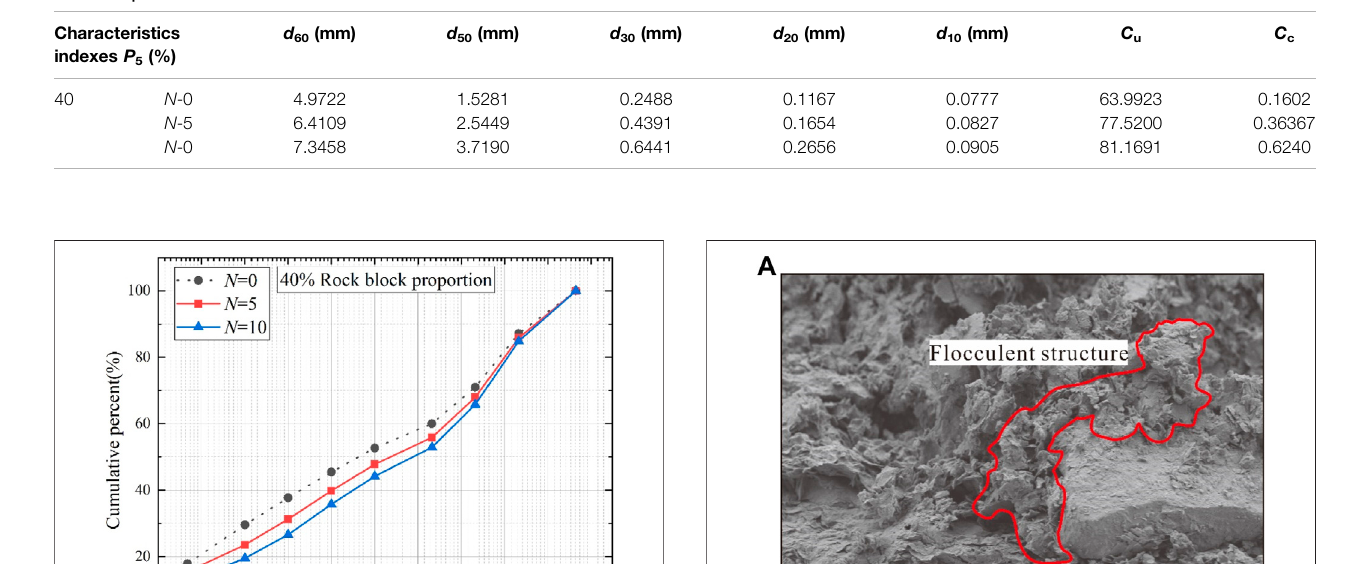
TABLE 2 | Statistical results of S-RMs characteristic indexes.